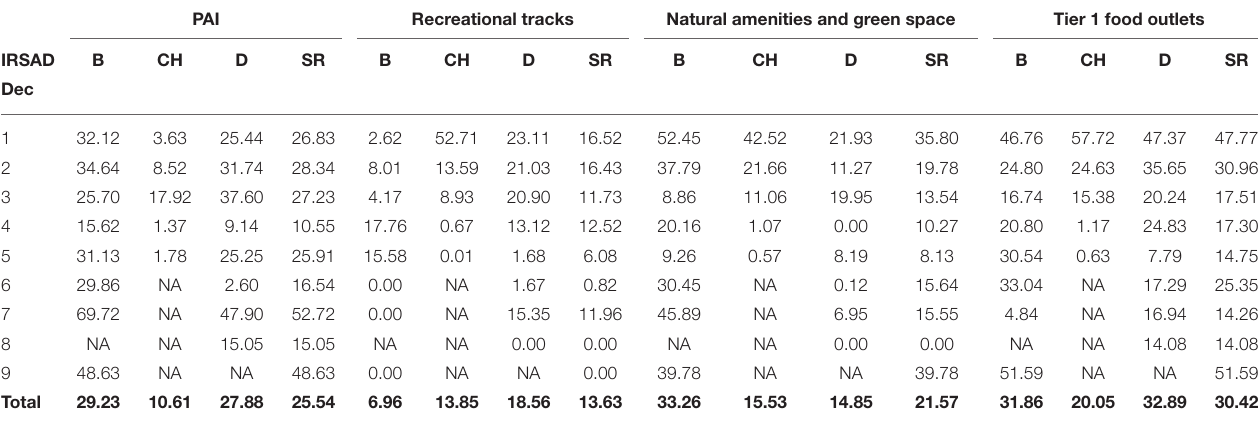
TABLE 5 | Proportion of the population in each region with limited access to PAI and food outlets based on IRSAD. PAI Recreational tracks Natural amenities and green space Tier 1 food